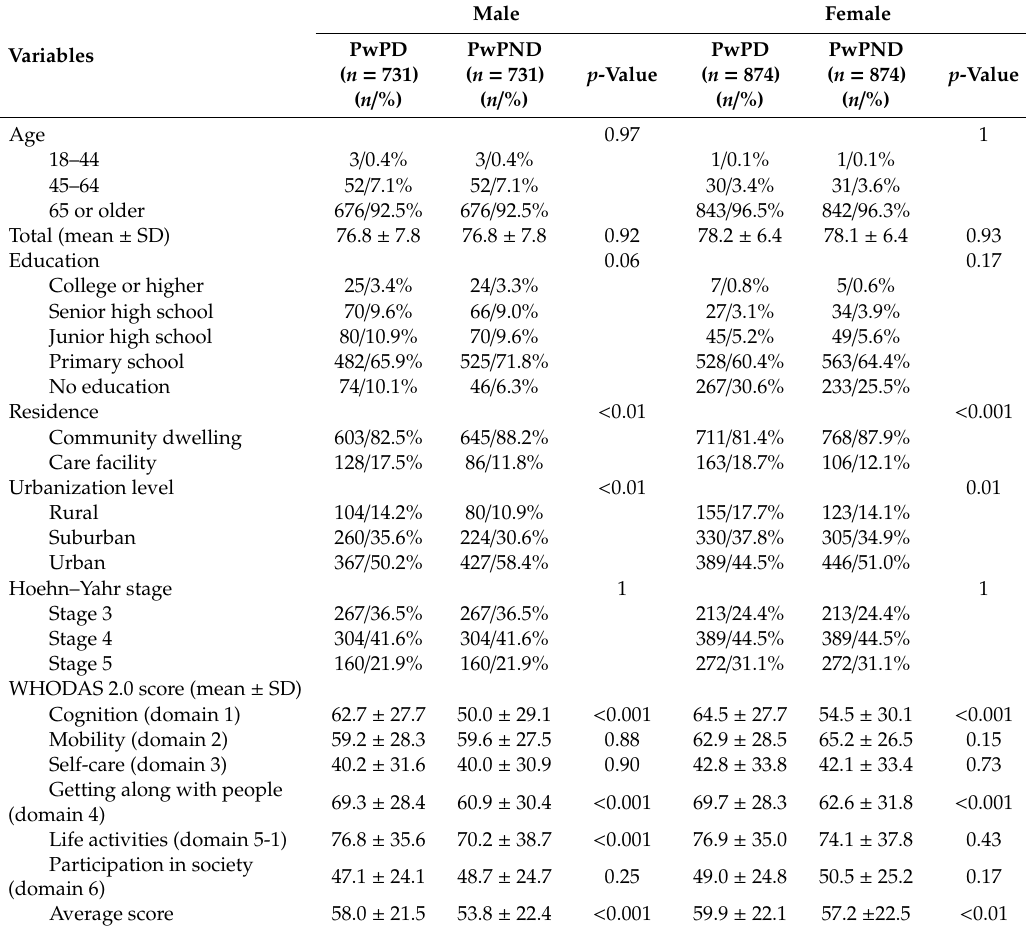
Table 2. Demographic data of the matched population ( n =